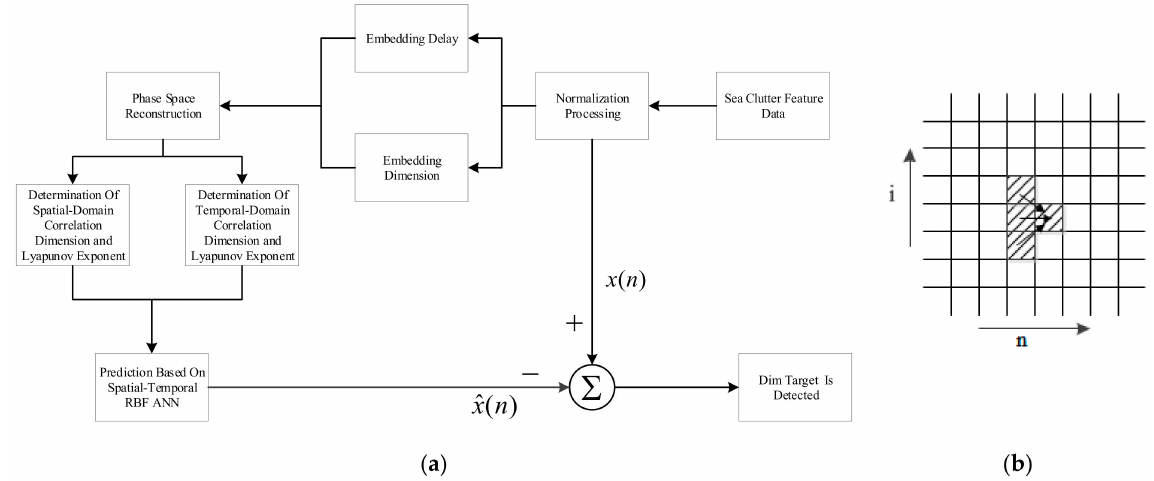
Figure 4. The proposed algorithm. ( a ) The flow chart. ( b ) The direction of the temporal domain and the spatial